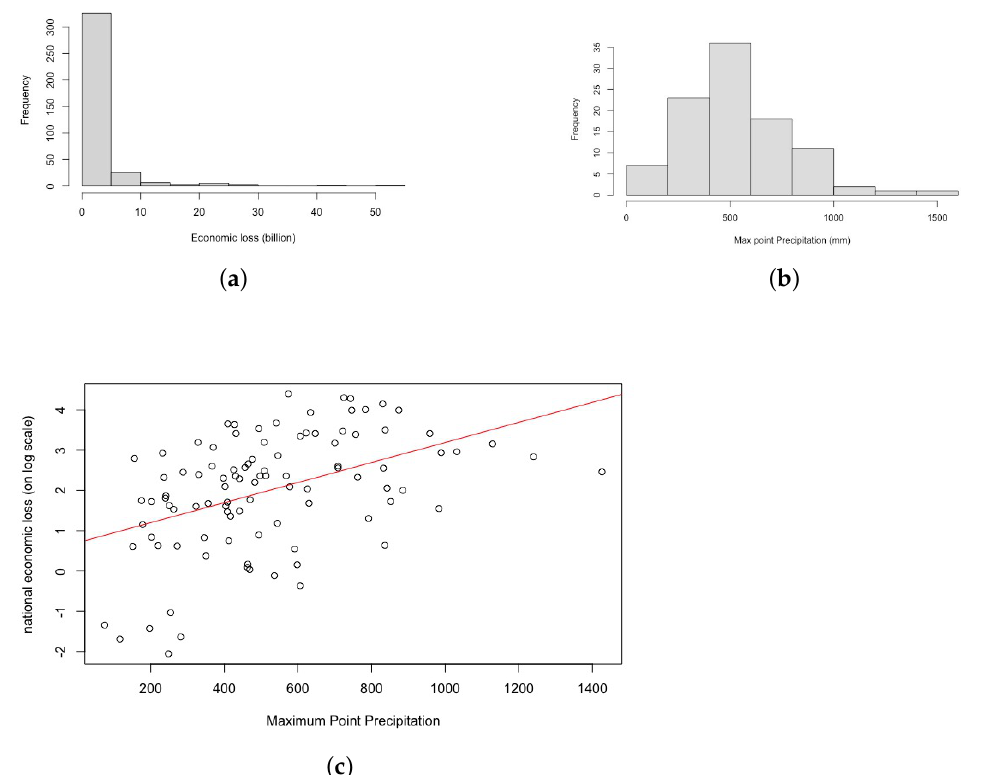
Figure 2. Histogram of ( a ) economic loss and ( b ) maximum point precipitation, and ( c ) scatter plot of economic loss in billion yuan on log scale against maximum point precipitation in